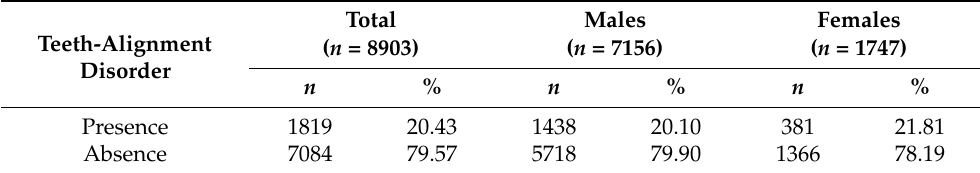
Table 1. The rate of the presence/absence of awareness of teeth-alignment disorder in the study population.